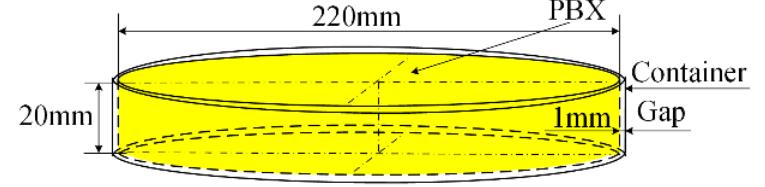
Figure 1. Thin PBX in a limited space container.